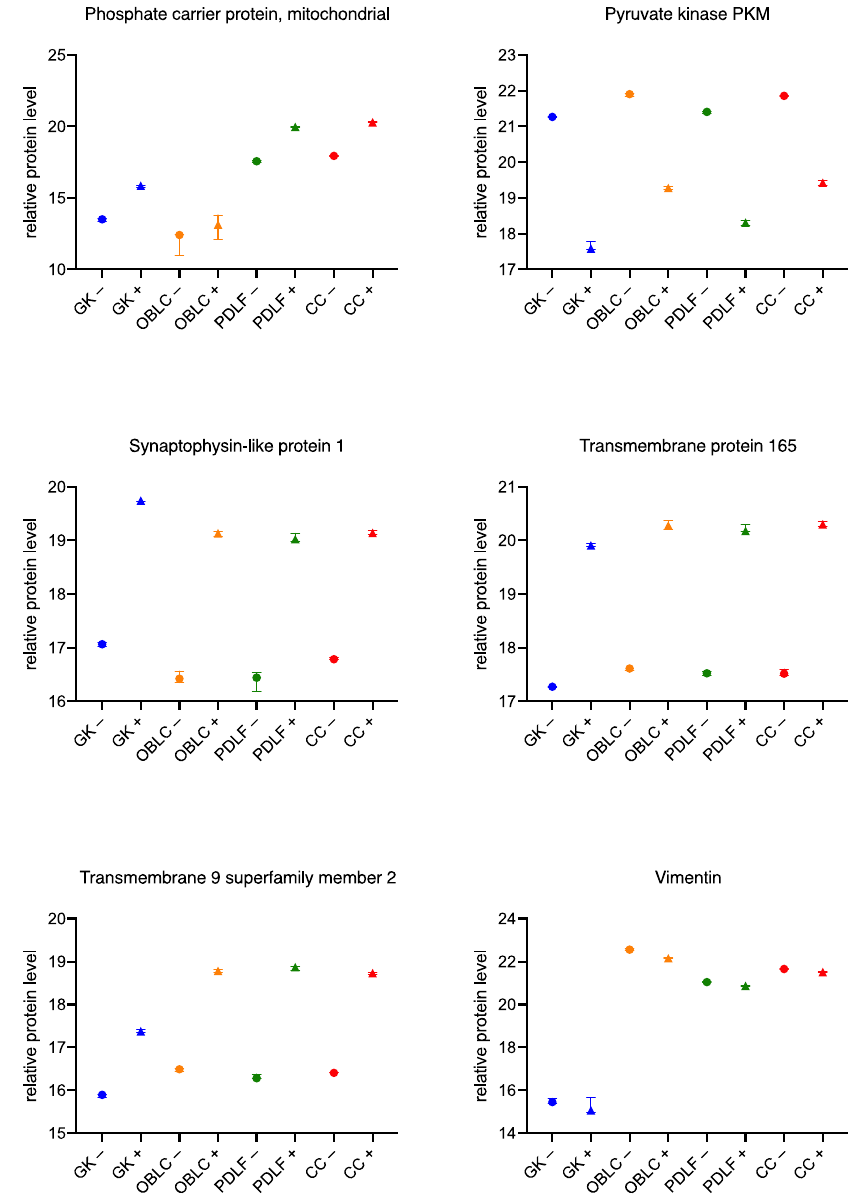
Figure 8. Significant concordances in the behavior of individual cells during culture with bacteria Part 2. Protein peak areas were transformed with a log2 scale, and bacterial conditions were compared pairwise with standard conditions using a Student’s t -test ( p < 0.05) and Benjamini-Hochberg correction for multiple testing. “+” indicates culture with bacteria; “ − ” indicates culture without bacteria.